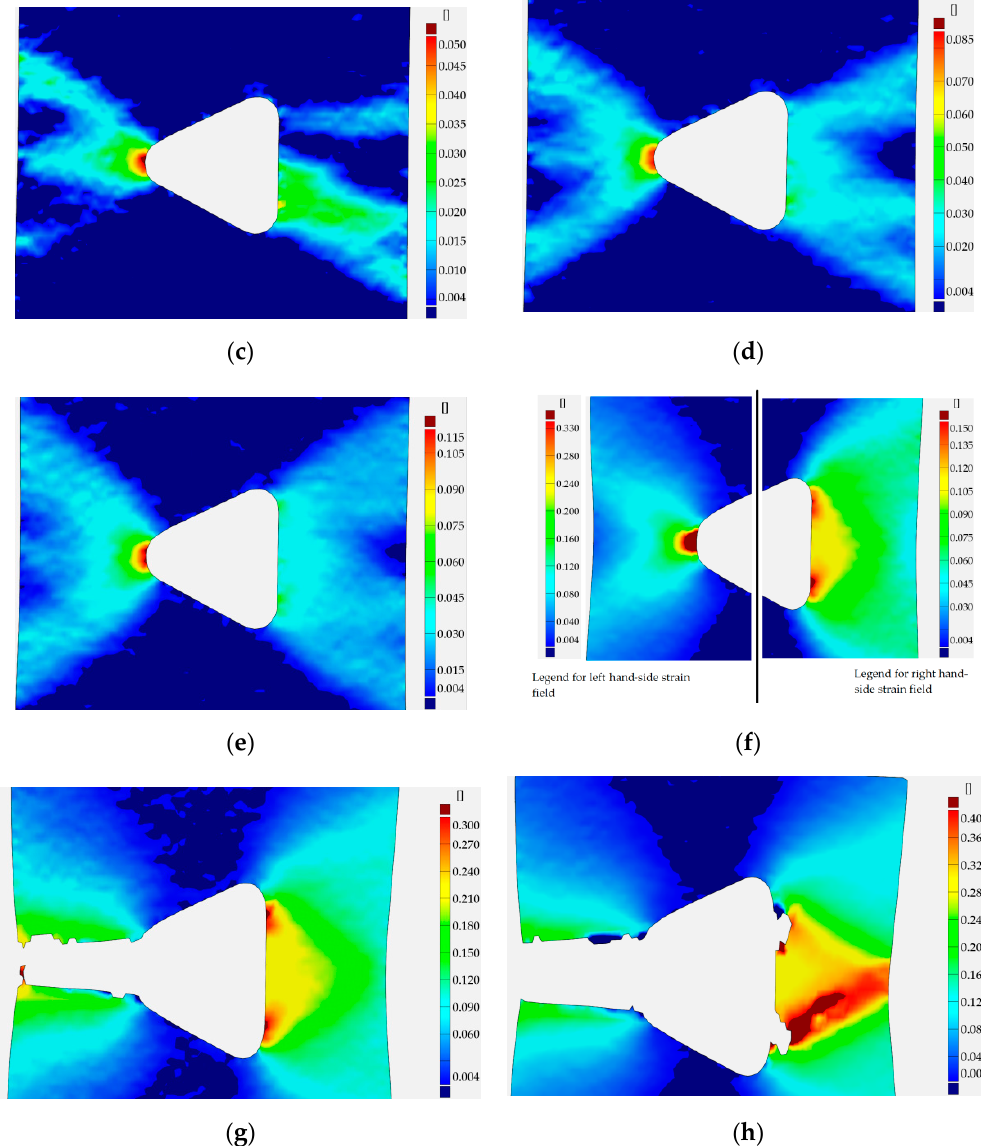
Figure 25. Strains field on investigated surface of plate made of S235JR + N with triangular hole calculated with the use of DIC; total vertical displacement u MTS and corresponding vertical ε TOT (in brackets): ( a ) 0.83 (0.46); ( b ) 0.91 (0.505); ( c ) 1.16 (0.644); ( d ) 1.58 (0.876); ( e ) 2.08 (1.16); ( f ) 5.91 (3.28); ( g ) 10.43 (5.79); and ( h ) 15.1 (8.39).